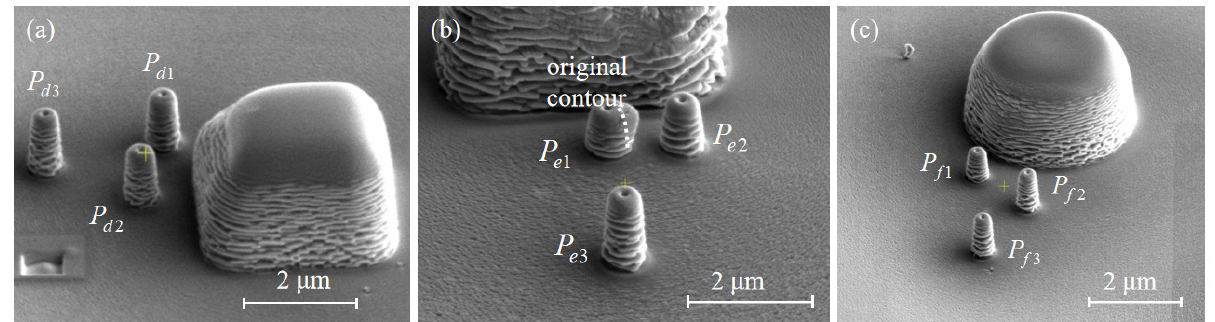
Figure 7. ( a ) Pillars P d 1 , P d 2 , and P d 3 grown behind the diamond shading structure; ( b ) pillars P e 1 , P e 2 , P e 3 grown behind the rectangular shading structure; ( c ) pillars P f 1 , P f 2 , P f 3 grown behind the circular shading structure.